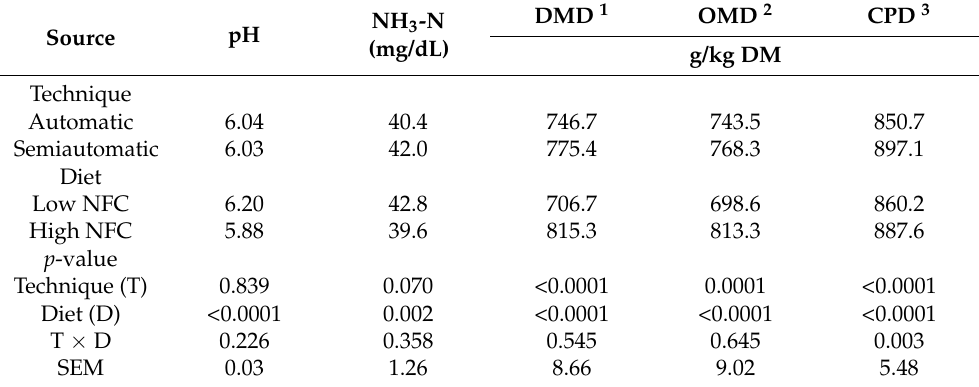
Table 3. Rumen parameters and nutrient degradability at 48 h of incubation as a function of two gas production measurement techniques, two diets and the “diet × technique” interaction for crude protein degradability (CPD).